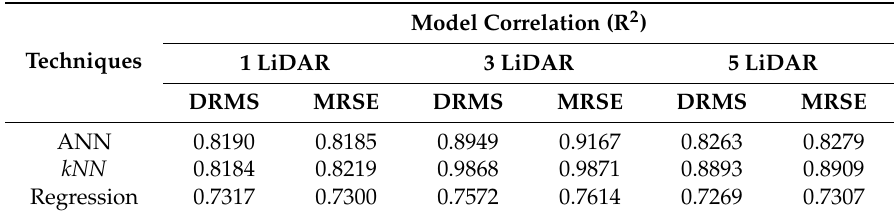
Figure 7. Flow diagram of the self-tuning method for the IoT sensor dynamic obstacle detection scenario. Table 5. Behavior of the correlation (R 2 ) of each type of model according to the number of LiDAR sensors used at any one given